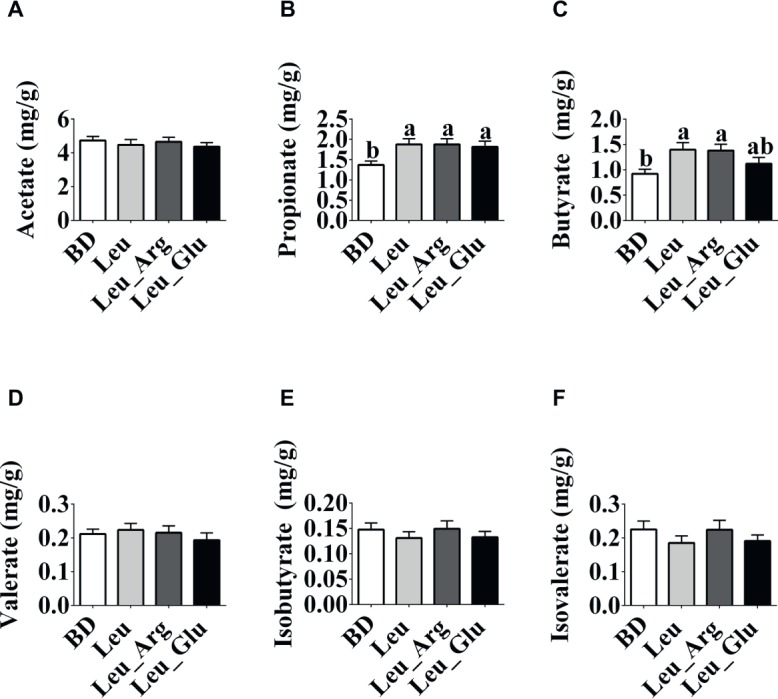
The SCFAs concentrations in the colonic contents in finishing pigs. (A-F) Colonic acetate, propionate, butyrate, valerate, isobutyrate, and isobutyrate concentrations, respectively. Data represent the means ± SEM. a,bindicate statistically significant differences (p < 0.05).